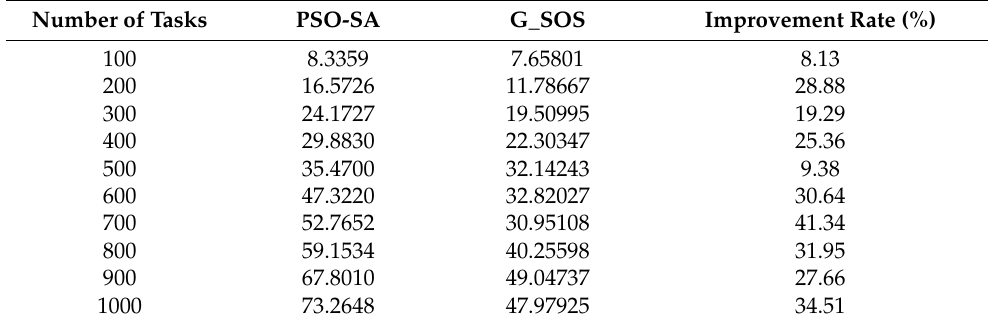
Table 9. Comparison of the Response Time of PSO-SA and G_SOS for a uniformly distributed dataset.